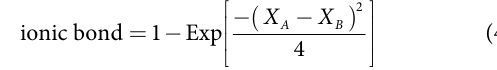
κ . κ ) of a nanostructured l e